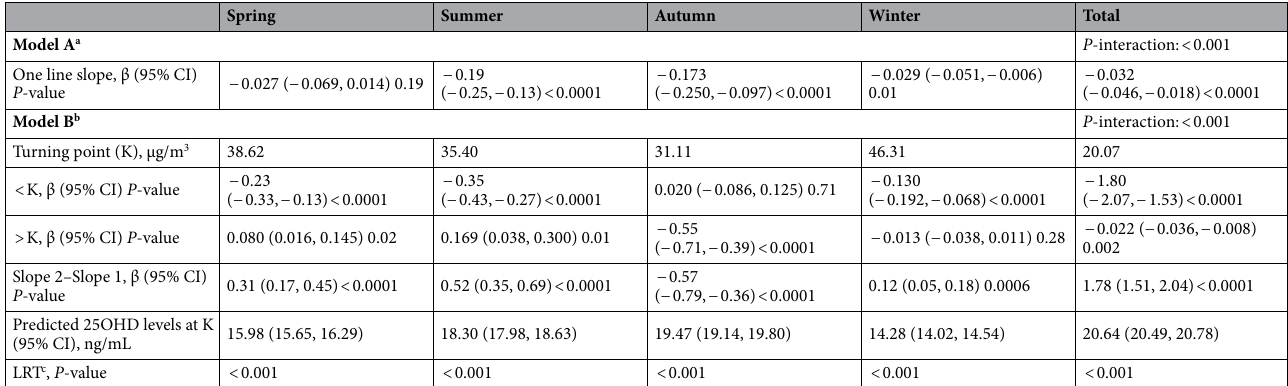
Table 3. Threshold effect analysis examining associations between 45-day moving daily average PM 2.5 levels and maternal serum 25OHD levels during second trimester in subgroups stratified by season of blood collection. PM 2.5 particulate matter with an aerodynamic diameter of ≤ 2.5 μm, 25OHD 25-hydroxy vitamin D, CI confidence interval, LRT logarithmic likelihood ratio test. Adjusted for year, age, 45-day moving daily average atmospheric pressure, sunshine duration, relative humidity and wind speed. a Linear analysis, P -value < 0.05 indicates a linear relationship. b Non-linear analysis. c P < 0.05 means Model B is significantly different from Model A, which indicates a non-linear relationship.